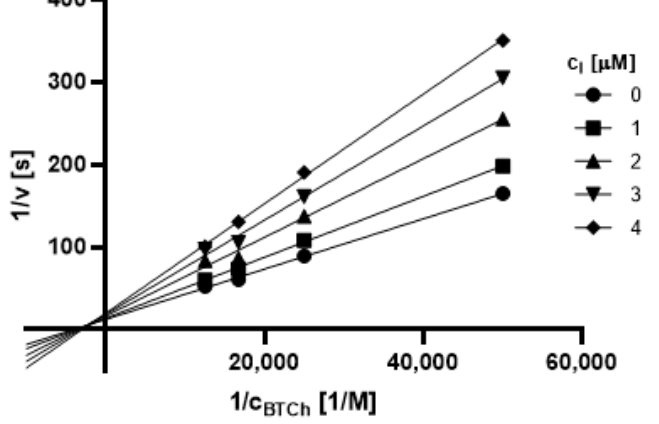
Figure 14. Lineweaver–Burk plot for 2e and BuChE inhibition (BTCh = butyrylthiocholine).